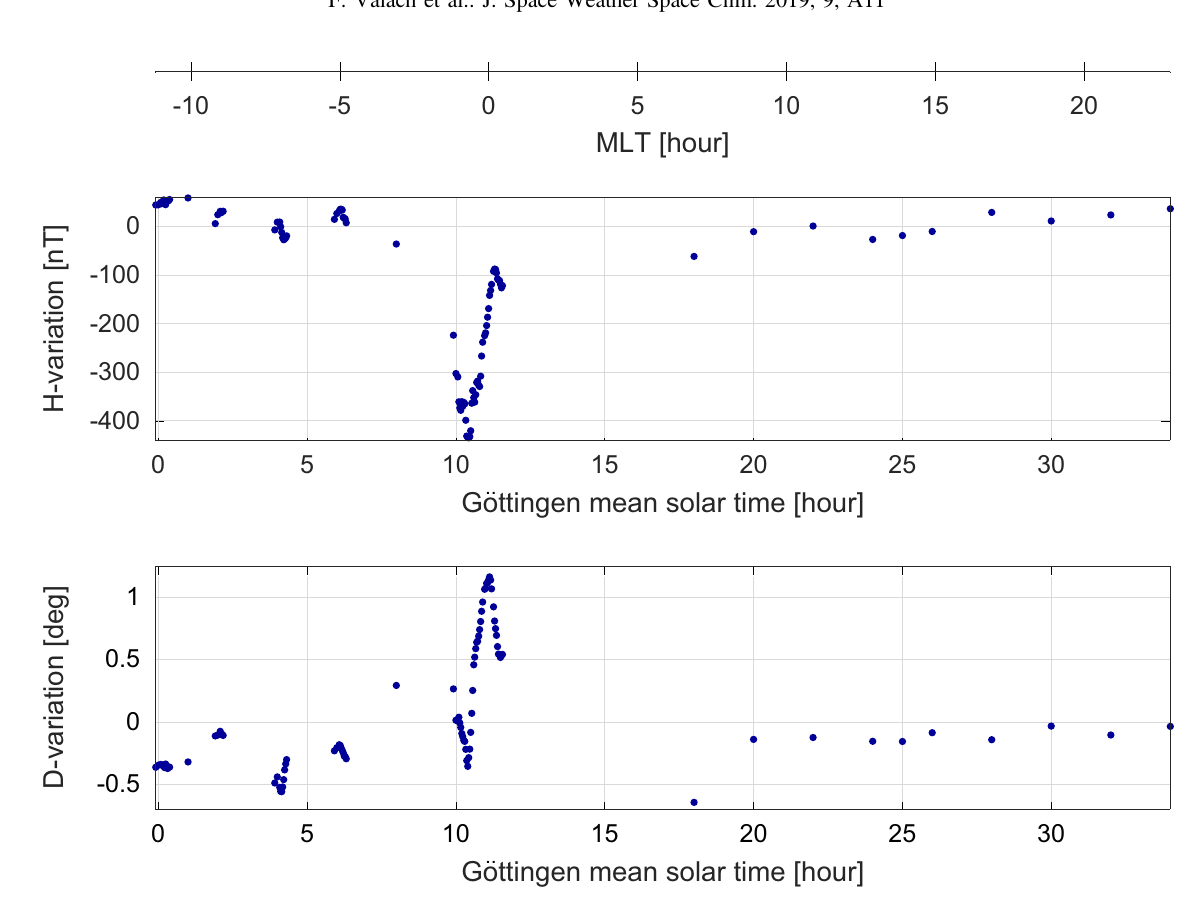
Fig. 1. The variations of the horizontal intensity and declination that were recorded at the Clementinum observatory on 17 November 1848 (Kreil & Jelinek, 1850). The additional time axis at the top of the fi gure shows the magnetic local time (MLT).